Question: Reading the figure, is the described quantity rising or falling?
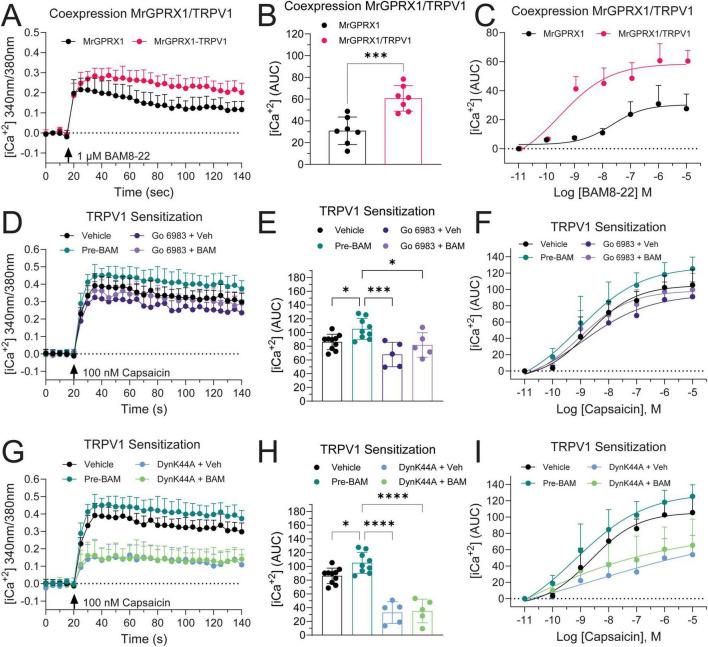
Answer: decreasing